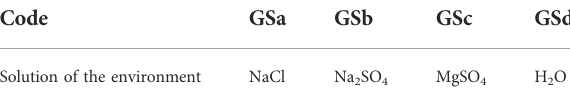
TABLE 5 Specimen codes of different solution